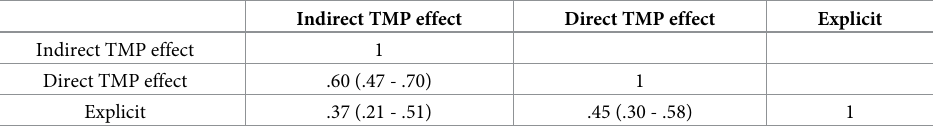
Table 5. Correlations between measures for scores based on “men-vs-women” relations. All p s for correlations <